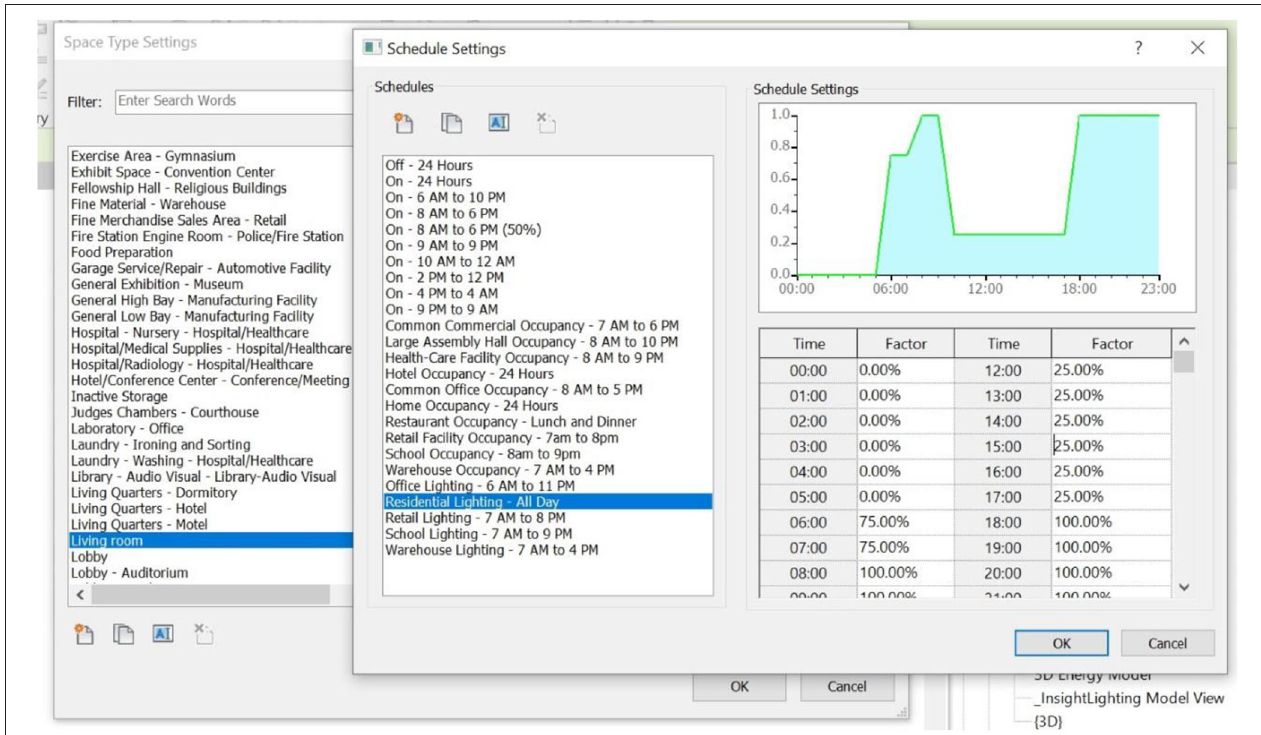
FIGURE 16 | Customized operation schedule.